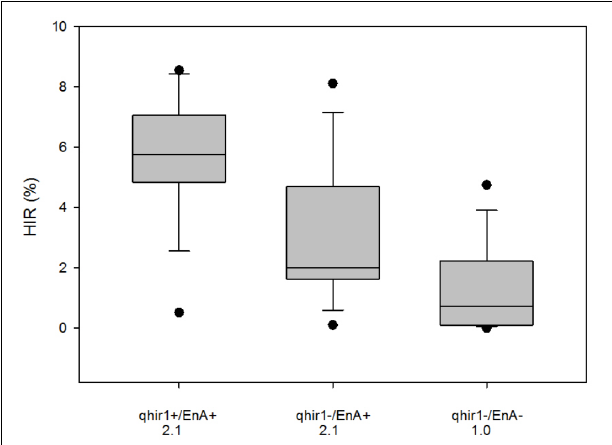
FIGURE 4 | HIR of three F3 categories of plants selected from the F2 population CKL0159 x 2GTAIL006. Fifteen plants were assessed for HIR from each category. qhir1+/qhir1– indicates presence/absence of QTL qhir1 in the F2 plants. EnA+/EnA– indicates presence/absence of endosperm abortion in the F2 ears. Mean values for endosperm abortion score were indicated for each category on the